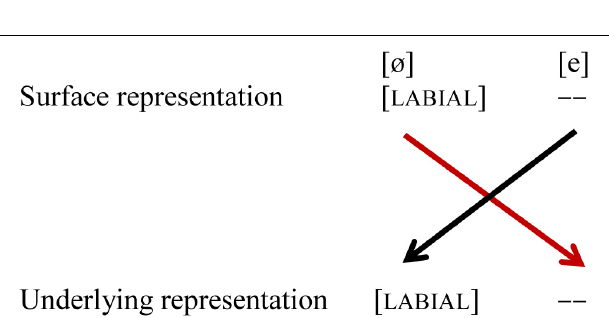
the direction of change in which the largest MMN is expected. During testing, surface features of the deviant [] are mapped onto the underlying features of the standard //. The predictions are conform the asymmetries in this paper, but the NRV makes predictions depending on closeness or convergence (based on